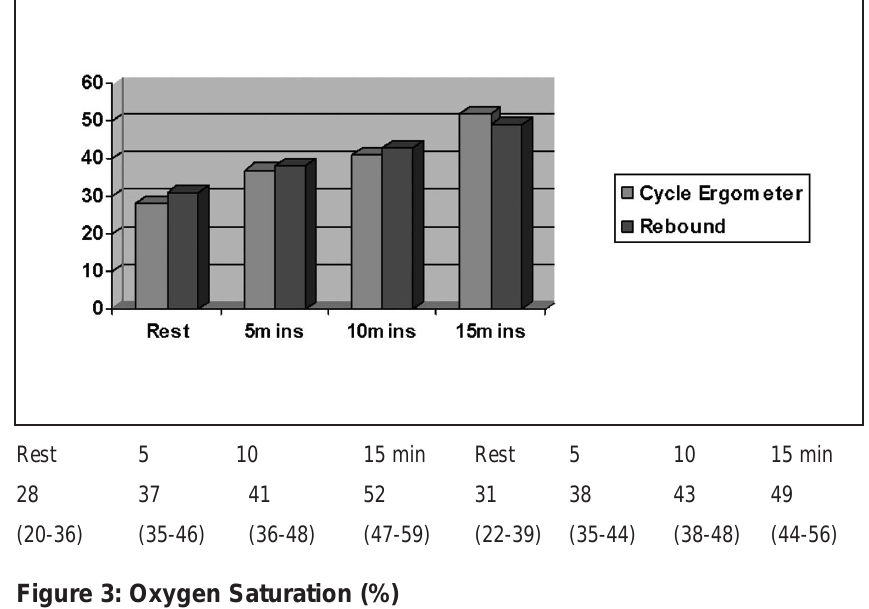
Figure 2: Respiratory rate (per minute)